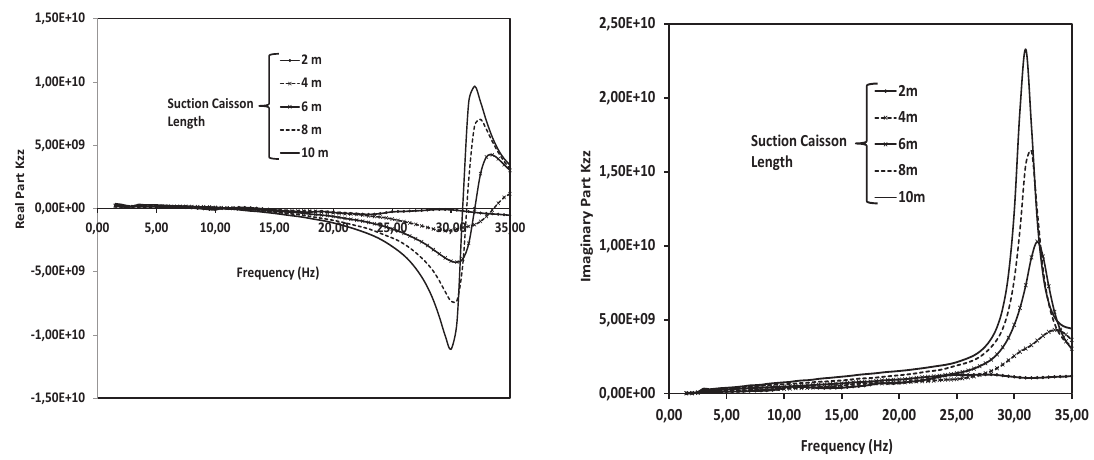
Figure 9 Vertical and horizontal response for the maximum │U/F│̶ Influence of the suction caisson diameter